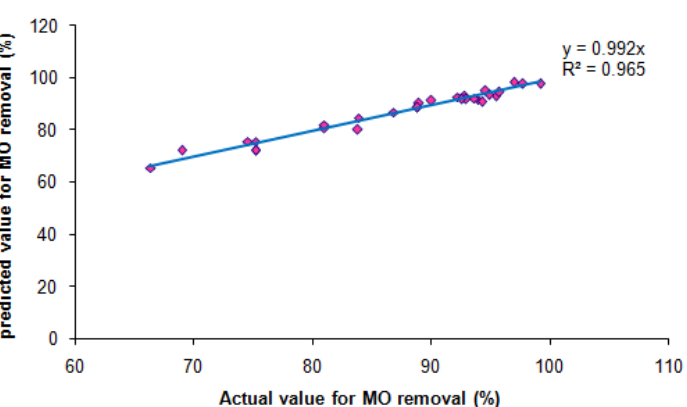
Fig. 10. Plot of the predicted value of MO removal versus actual